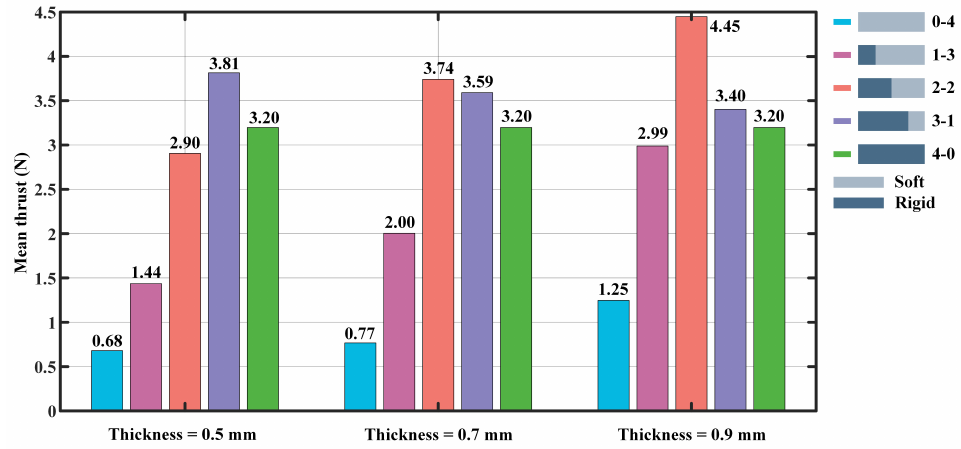
Figure 6. The mean thrust produced by the foil at the flapping frequency of 1 Hz, averaged over all flapping angles from 20° to